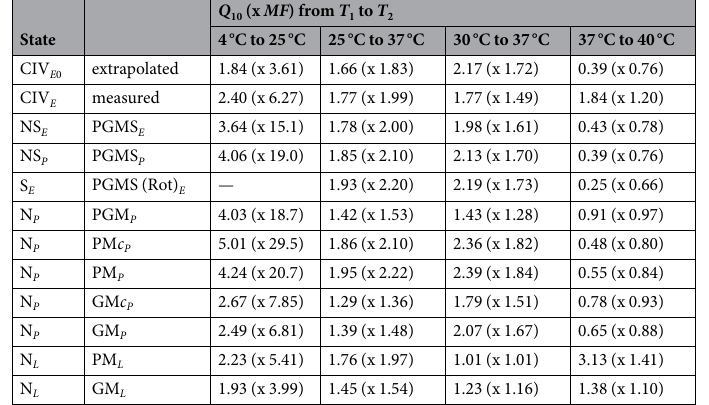
Table 1. Effect of temperature on mitochondrial respiration as a function of metabolic state in permeabilized mouse heart fibers. Q 10 is the multiplication factor for an increase by 10 °C, calculated for respiratory flux, J , in the experimental temperature intervals, T 1 to T 2 . Numbers in parentheses are multiplication factors ( MF = J T 2 / J T 1 ) to convert J from T 1 to T 2 . Q 10 and MF are medians ( n = 4–16). Q 10 = MF exp (10/( T 2 − T 1 )). Cytochrome c oxidase activity was measured with 2 mM ascorbate and 500 µ M TMPD (CIV E ) or